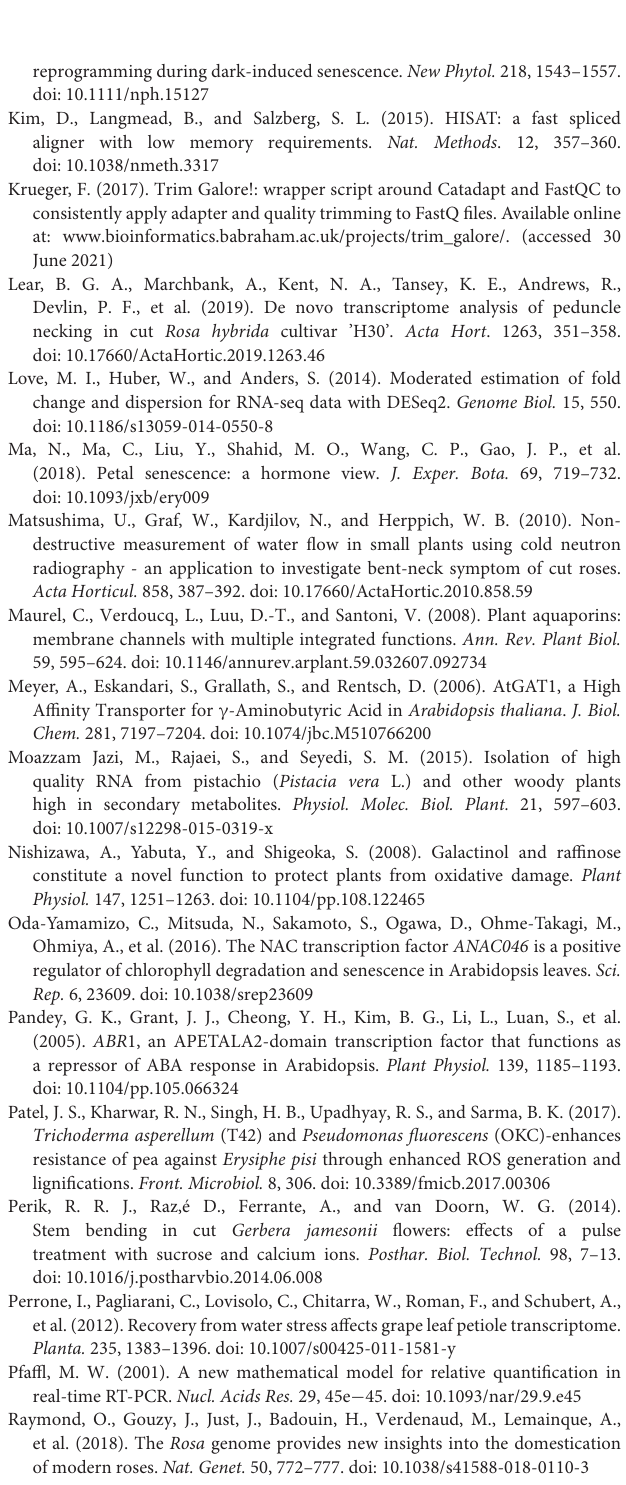
Supplementary Figure 3 | Differential gene expression amongst necking stages in cv. H3O peduncles. Supplementary Figure 4 | Gene ontology (GO) terms identified using AgriGO v2.